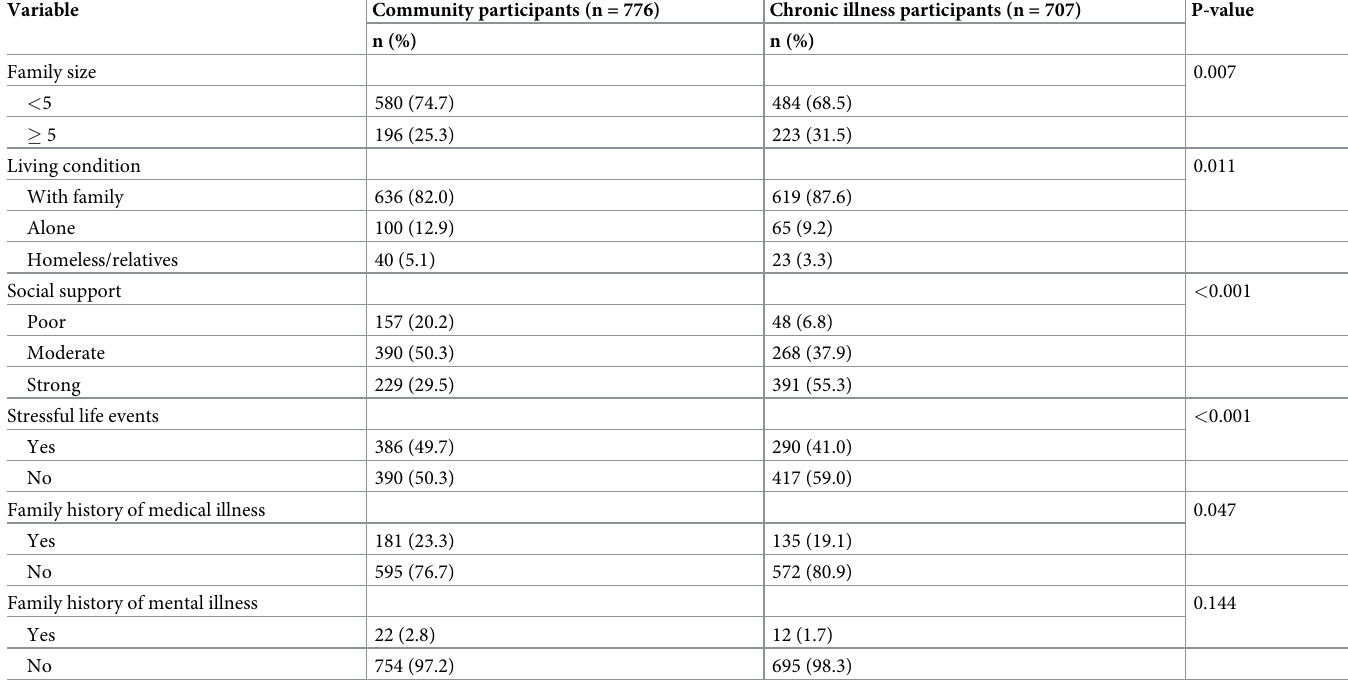
Table 2. Psycho-social factors among people living with chronic medical illness and general community participants in Mecha demographic research center,